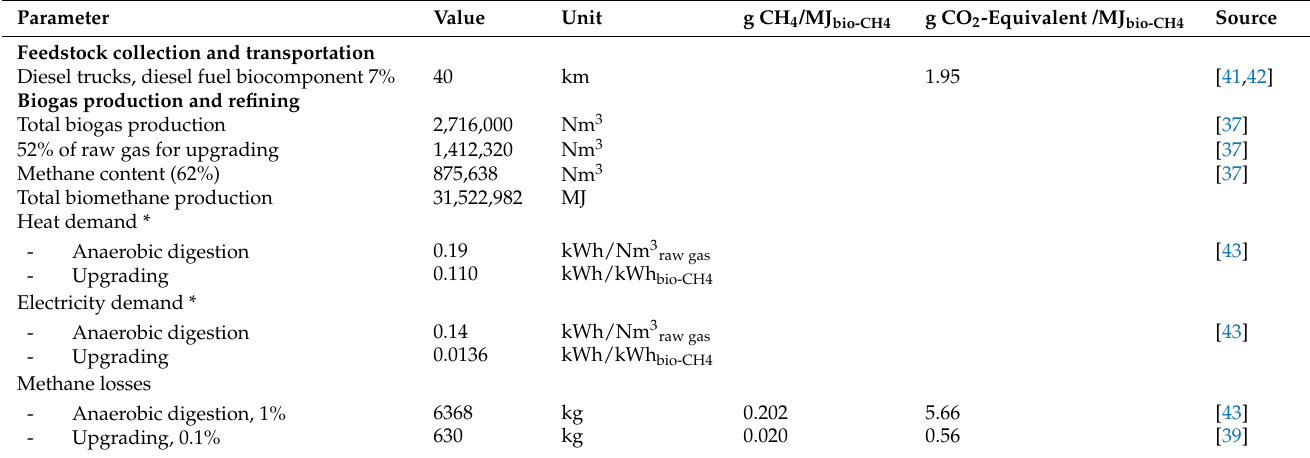
Table 6. CBG well-to-tank GHG